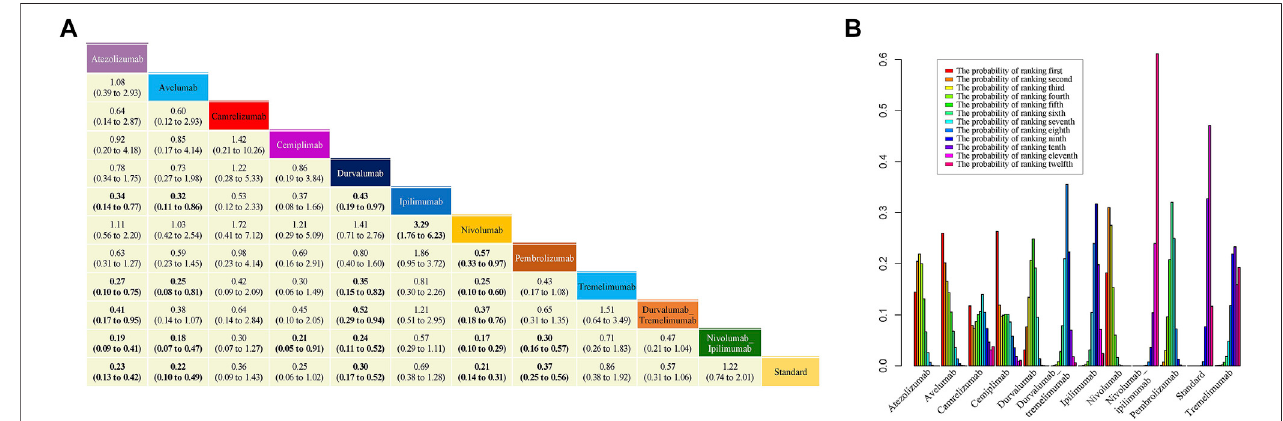
FIGURE 5 | Results of NMA, safety pro fi le (A) and probability ranking diagram (B) . In the safety pro fi le, ef fi cacy of treatment for grade 3 – 5 adverse events is represented as odd ratios (ORs) with 95% con fi dence intervals. All comparisons are made as column versus row. Statistically signi fi cant results are in bold. Probability ranking diagram shows the probability of the safety of different therapies ranking the fi rst to the last for severe adverse